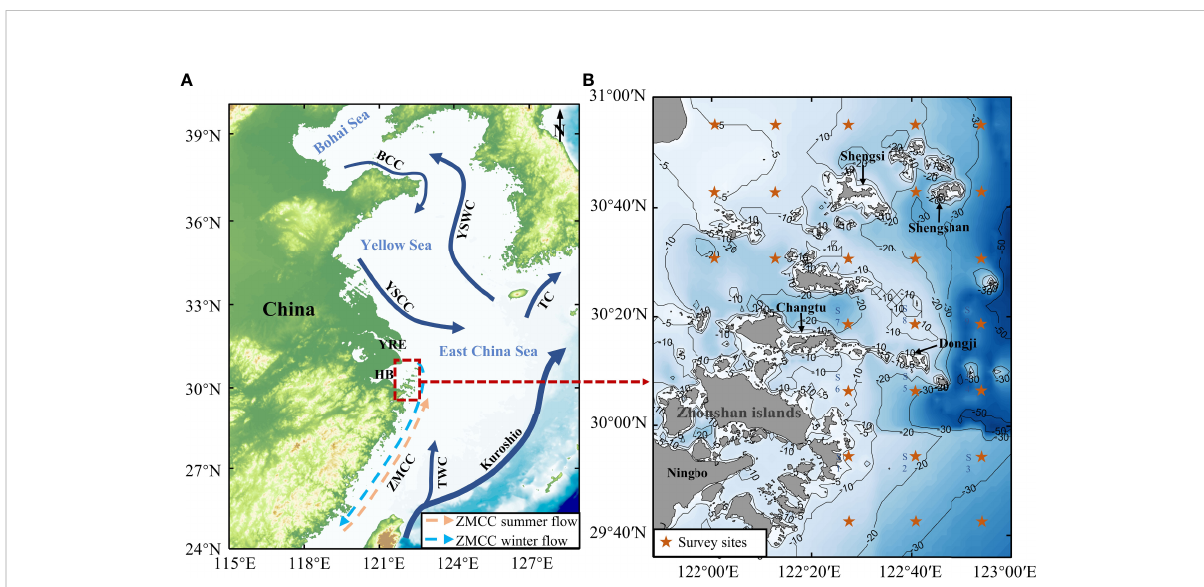
FIGURE 1 The study area. (A) The location of the Zhoushan archipelago. YRE: Yangtze River Estuary; HB: Hangzhou Bay; BCC: Bohai Coastal Current; YSWC: Yellow Sea Warm Current; YSCC: Yellow Sea Coastal Current; TC: Tsushima Warm Current; ZMCC: Zhemin Coastal Current; TWC: Taiwan Warm Current. (B) Enlarged view of the survey site and adjacent shelf waters in the Zhoushan archipelago during autumn 2020. Orange mark: observation